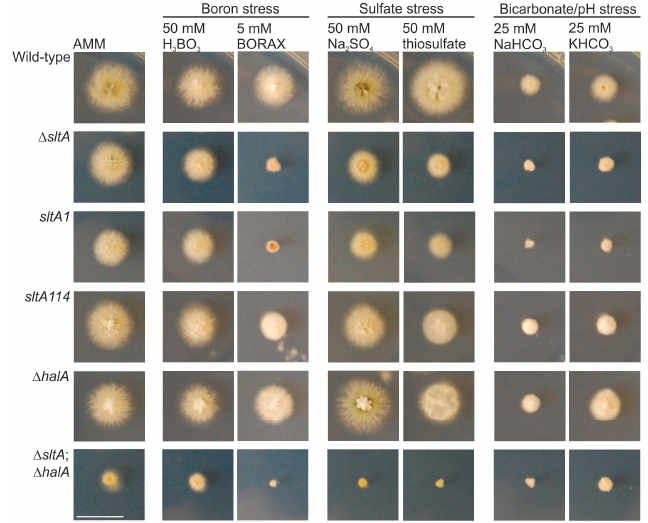
Figure 2. Sensitivity of loss-of-function sltA mutants to stress. Phenotype of wild-type, Δ sltA , sltA 1, sltA 114, Δ halA and Δ sltA ; Δ halA strains after 48 h of cultivation at 37 °C in AMM (Aspergillus minimal medium) and AMM with 50 mM boric acid, 5 mM Borax, 50 mM sodium sulfate, 50 mM thiosulfate, or 25 mM of sodium or potassium bicarbonate. Scale bar = 2 cm.